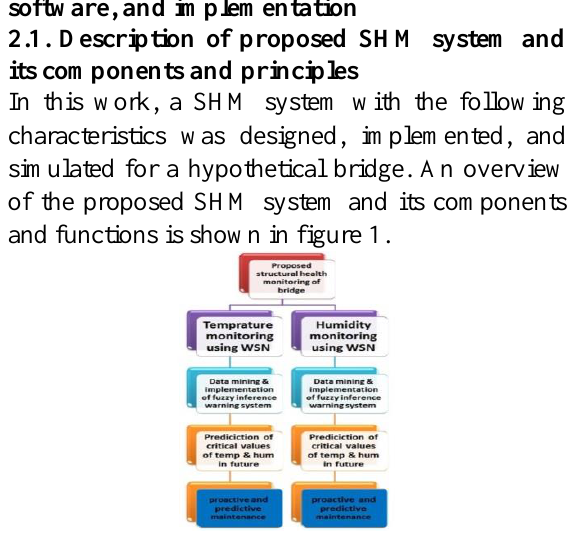
Figure 1. An overview of proposed SHM system and its components and function.